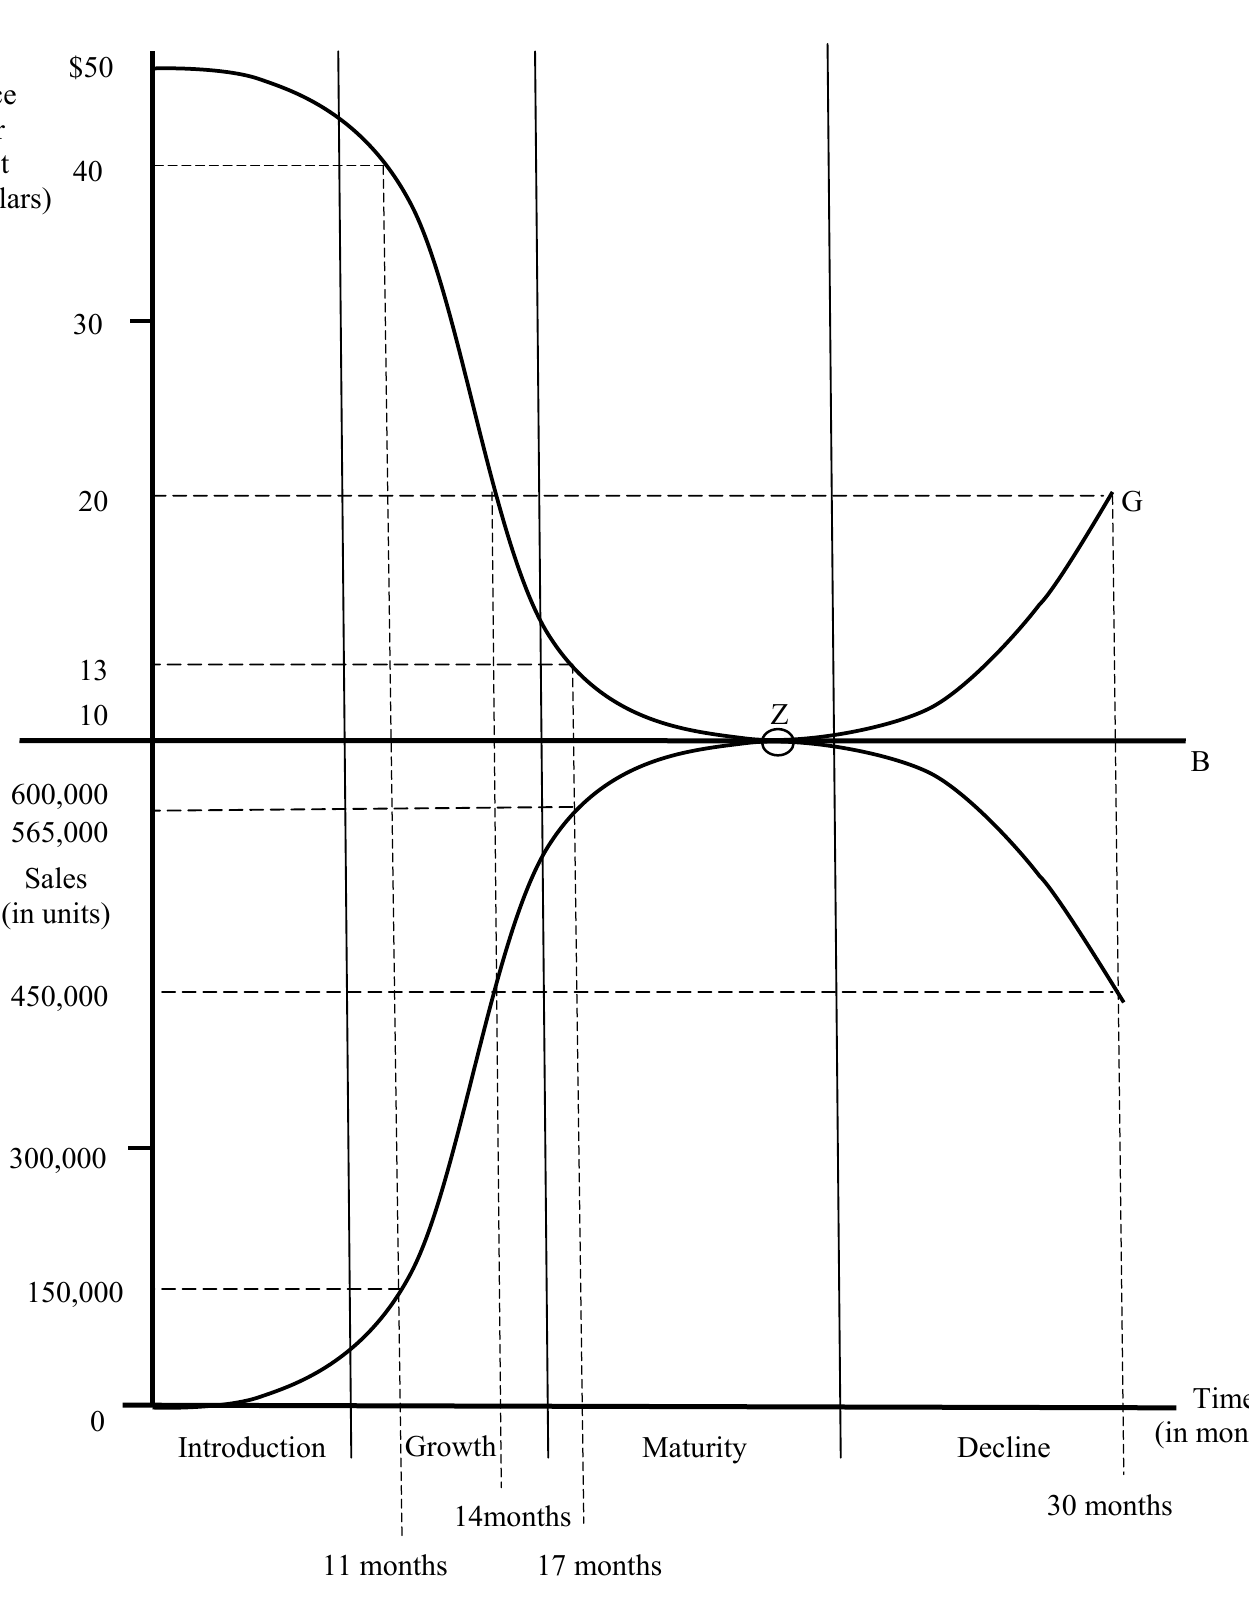
Fig. 3. Modified product life cycle and skimming price